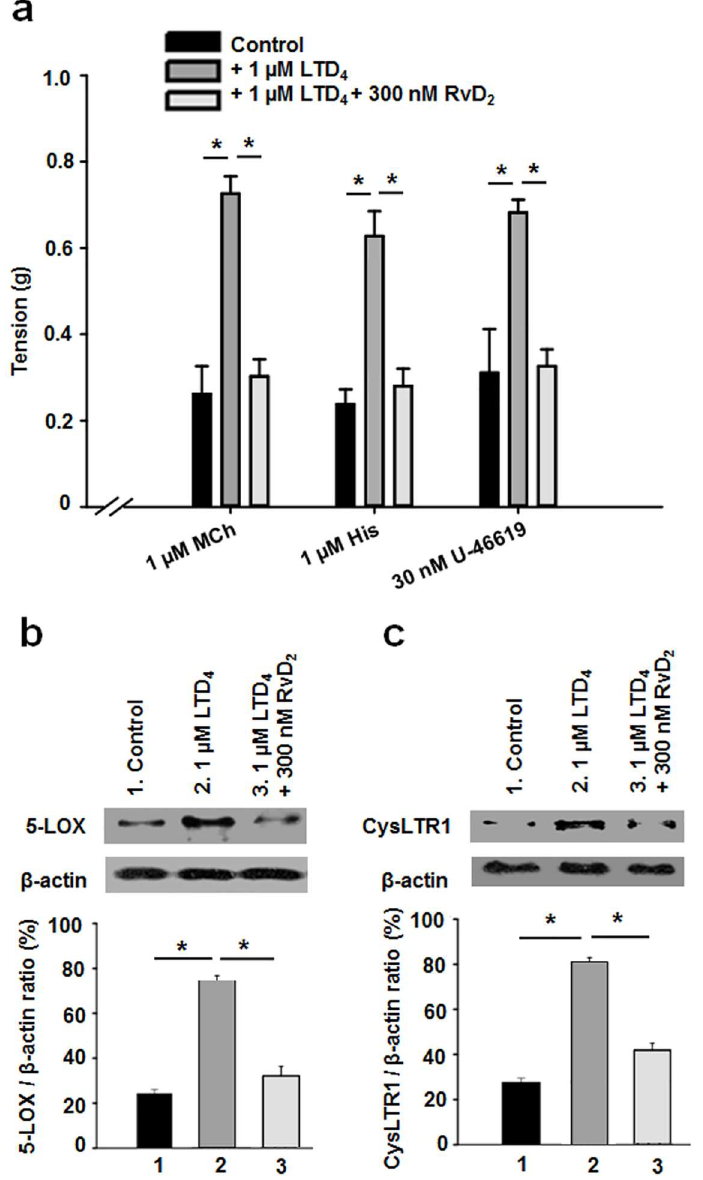
Fig 1. Effect of RvD 2 on LTD 4 –pretreated human bronchi in response to pharmacologically-induced tone and 5-LOX/CysLTR1 expression. a. Corresponding bar graph showingmean contractileamplitudes inducedby 1 μ M methacholine (MCh), 1 μ M histamineor 30 nM U-46619, either under control (untreated) conditions or after 1 μ M LTD 4 pre-treatment in the absenceor presenceof 300 nM RvD 2 (n = 7–22, * P < 0.05). b. Western blot analysesof the 5-LOX / β -actinratio assessingthe putative effects of 1 μ M LTD 4 and 1 μ M LTD 4 + 300 nM RvD 2 on humanbronchialhomogenates comparedwith control conditions ( n = 6, * P < 0.05). c. Western blot analysesusing CysLTR1 and β -actin antibodies. Densitiesof the immunoreactive bandsare expressedas a function of the β -actin-immunoreactive band ( n = 6, * P <